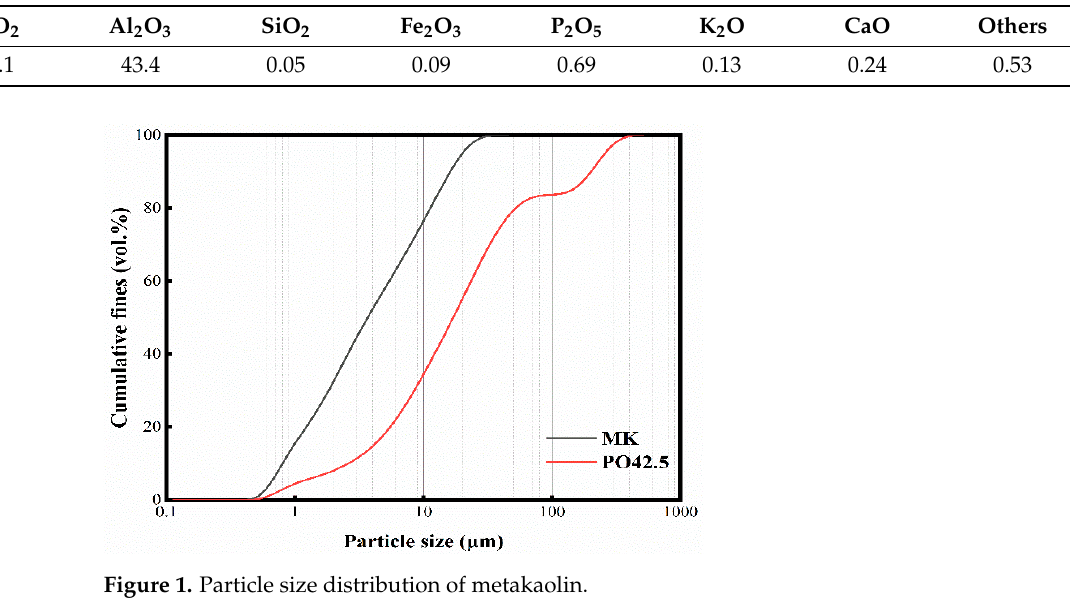
Table 1. Chemical composition of metakaolin. (%).